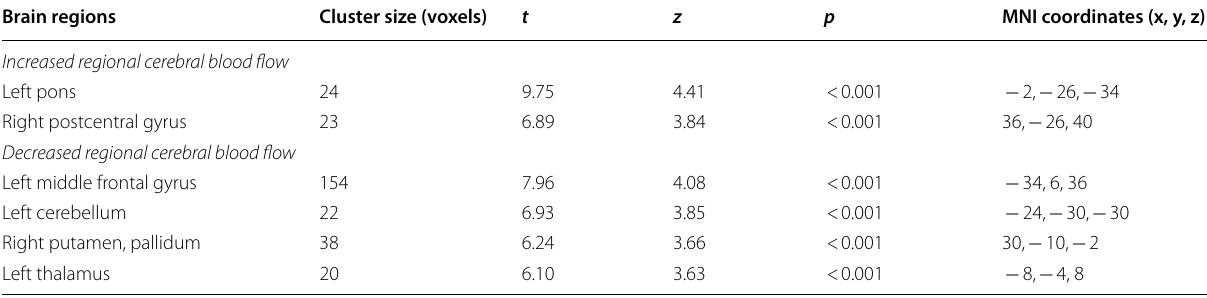
Table 1 Clusters with significant changes of regional cerebral blood flow in patients with dystonia after pallidal deep brain